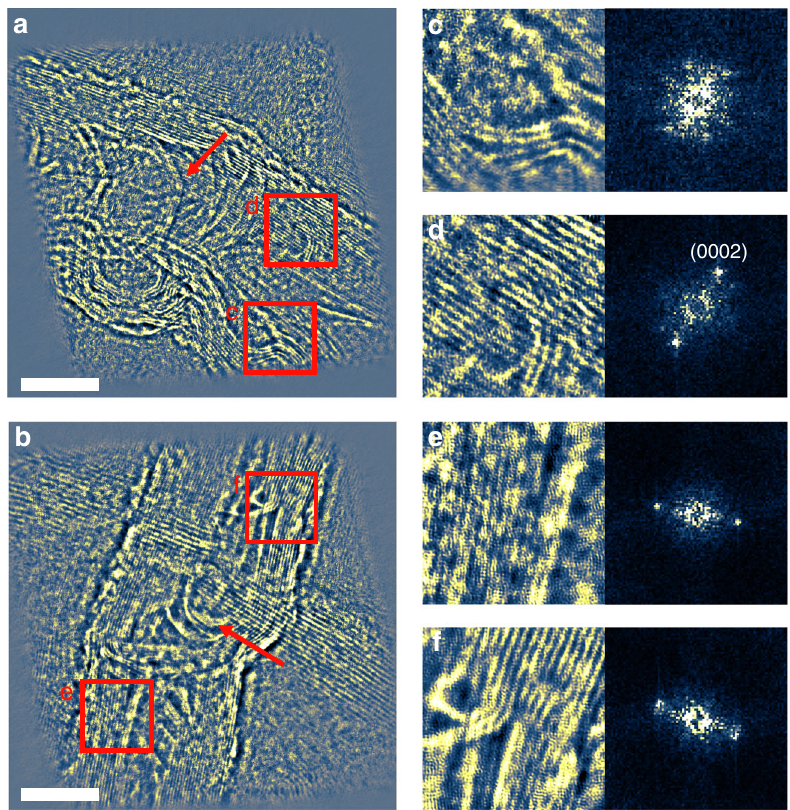
Fig. 3 Reconstructed phase in focus. a , b Phase of the upper and lower CNTs at Gaussian focus, respectively. c – f Magni fi ed views of regions indicated in a and b together with calculated power spectra. A lattice spacing of 0.34 nm in both CNTs is evident in both image and spectrum. Arrows indicate the compartment layers of the interior tube. Pixel size is 17 pm and the image size of a and b is 2400 × 2400 pixels. The 10 nm scale bar is the same for a –